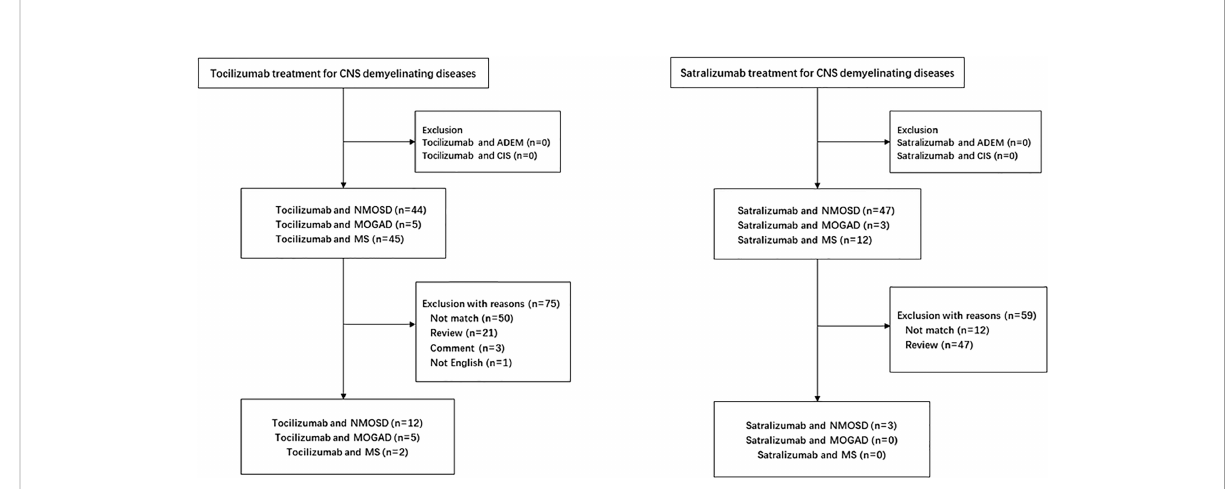
FIGURE 1 Flowchart enrolled in the